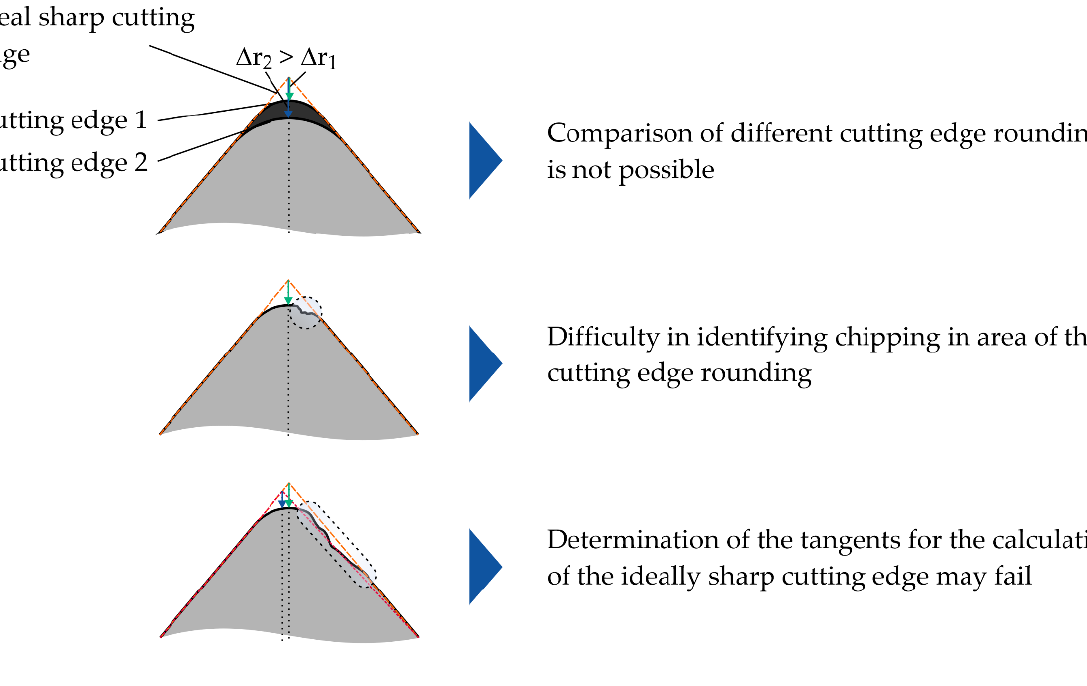
Figure 2. Disadvantages of the ∆ r-method in determining the cutting edge chipping.